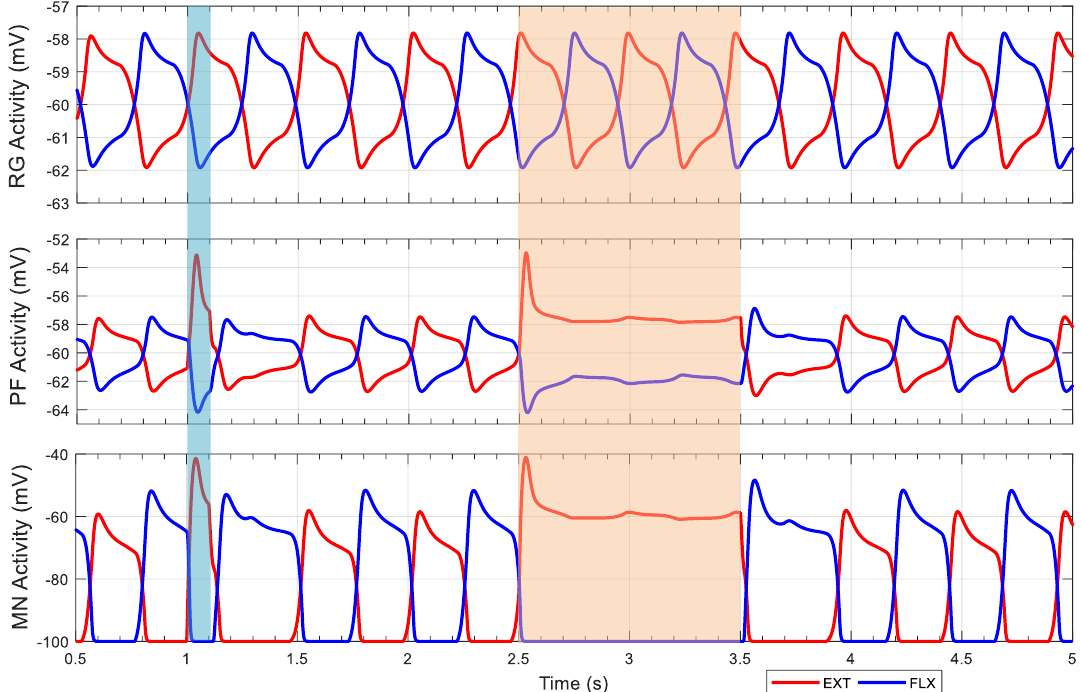
Figure 6. “Memory” function of a two-layer CPG. The first stimulus applied to extensor pattern formation neuron from 1 to 1.1 s (blue area) with a current of 2 nA and duration of 0.1 s is shorter than one swing–stance period. The second stimulus is applied from 2.5 to 3.5 s (orange area) with a current of 2 nA and duration of 1 s is longer than one swing–stance period. The simulation startup transients are not shown for the first 0.5 s. MN: Motoneuron; PF: Pattern formation; RG: Rhythm generation.